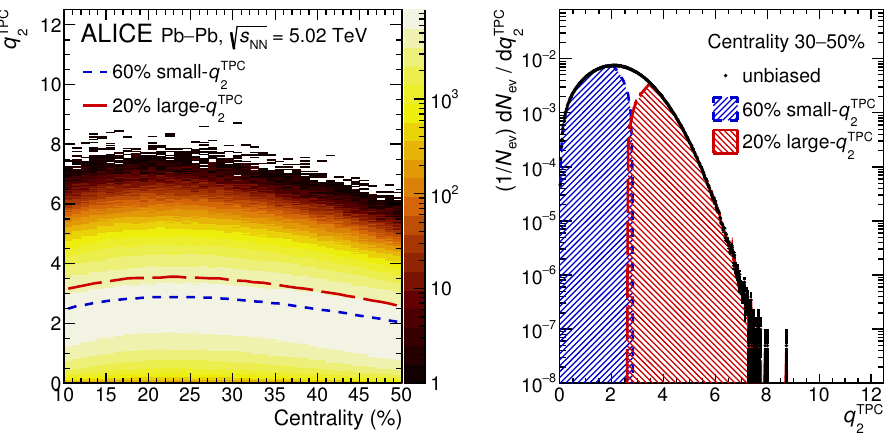
Figure 1 . Left: distribution of q TPC (see text for details) as a function of centrality in Pb-Pb 2 p collisions at s = 5 : 02 TeV. The red long-dashed and the blue short-dashed lines represent the NN limits for the 20% and the 60% of events with largest and smallest q TPC , respectively. Right: q TPC 2 2 distributions for the unbiased, small- q TPC and large- q TPC samples for the 30{50% centrality class 2 2 (see text for